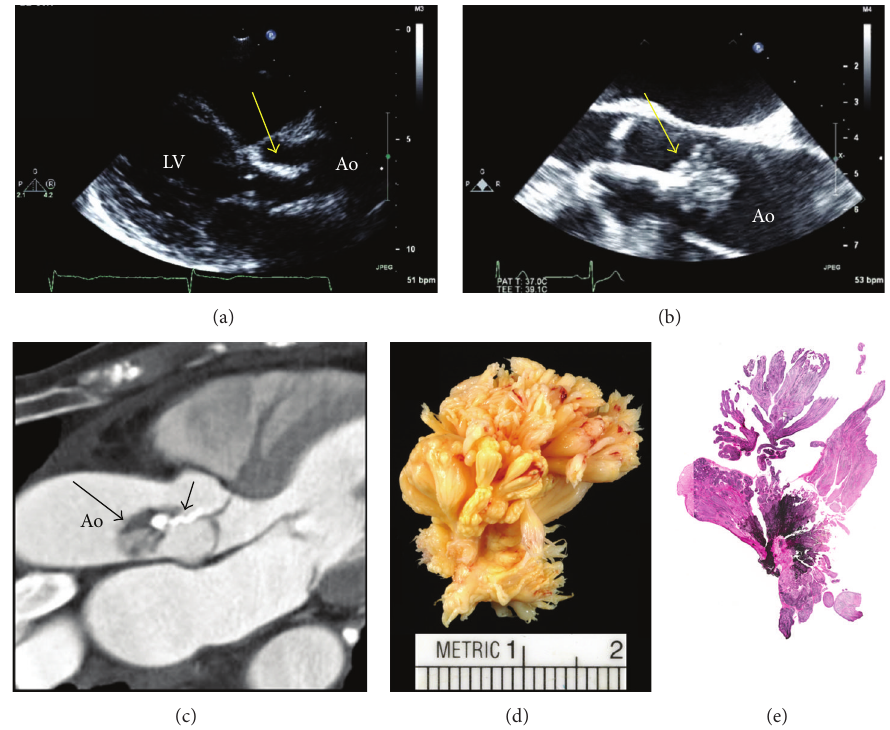
Figure 1: Transthoracic (a) and transesophageal echocardiography (b) imaging of a large pedunculated aortic valve mass (yellow arrows) subsequently identified as a papillary fibroelastoma (PFE). Cardiac-gated CT angiography (c) demonstrates the numerous papillary fronds (long arrow) emanating from the heavily calcified central stalk (short arrow). Following surgical resection, the mass was confirmed as a PFE by gross and histologic inspection (d) including Verhoeff-Van Gieson staining (e). Ao: aorta, LV: left